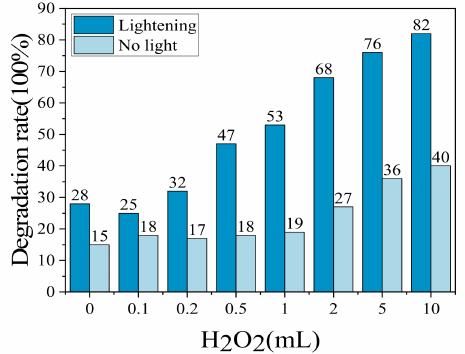
Figure 7. Effect of different amounts of H 2 O 2 on the degradation rate of